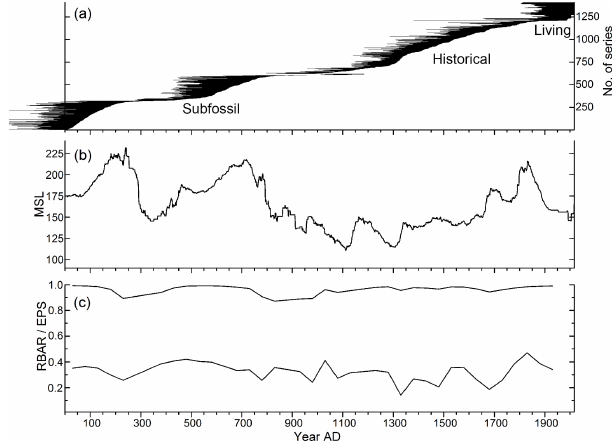
Figure 2. MR oak trees used for the reconstruction. (a) Growth period of living, historical and subfossil tree-ring series, (b) mean segment length (MSL) and (c) inter-series correlation (RBAR) and expressed population signal (EPS)